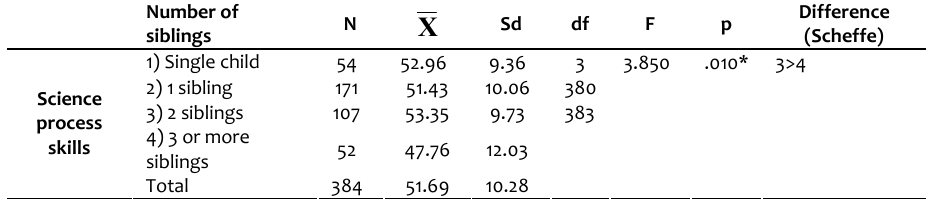
Table 14. Results of ANOVA on Science Process Skills of the 5-Year-Old Preschoolers According to Number of Siblings